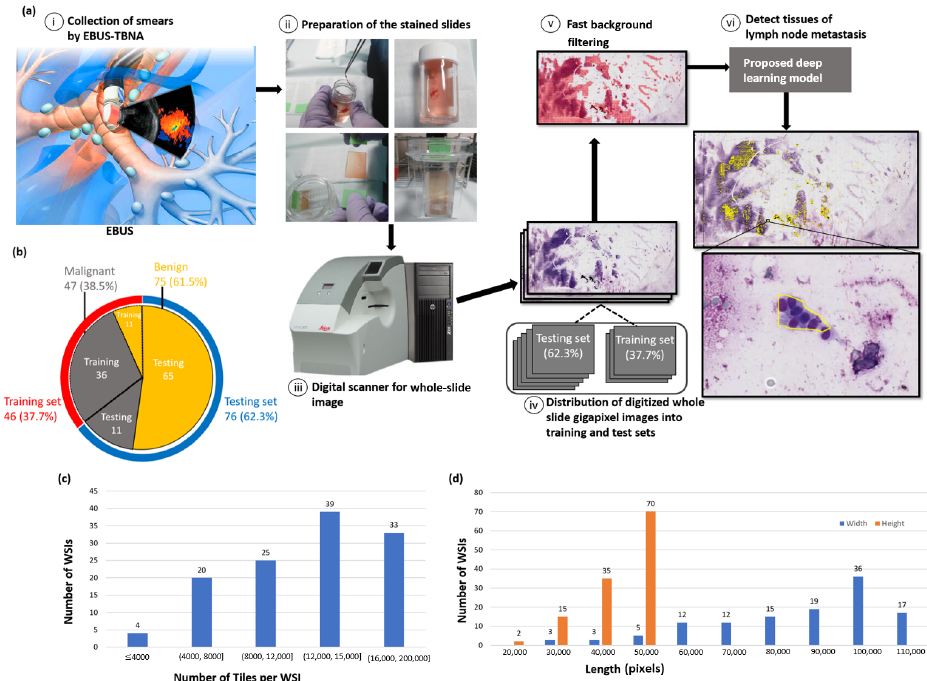
Figure 1. System workflow and dataset information. ( a ) System workflow; ( a , i) collection of patients’ lung smear samples through EBUS-TBNA; ( a , ii) preparation and staining of EBUS smears slides using Liu’s staining; ( a , iii) digitalization of Liu stained microscopic slides at the microscopic resolution (20 × magnification); ( a , iv) random distribution of digitized whole-slide gigapixel images into a separate training (37.7%) set and a testing (62.3%) set for the first experiment and a three-fold cross validation for the second experiment; ( a , v) processing of WSIs with fast background filtering; ( a , vi) rapid detection of enlarged mediastinal lymph nodes metastasis in EBUS-TBNA cytological slides using the proposed deep learning model in seconds. ( b ) Distribution of dataset for each class, as well as for training and testing sets for the first experiment and a three-fold cross validation for the second experiment. ( c ) Distribution of the number of tiles per WSI. ( d ) Size distribution of the WSIs, with width and height represented in blue and orange,